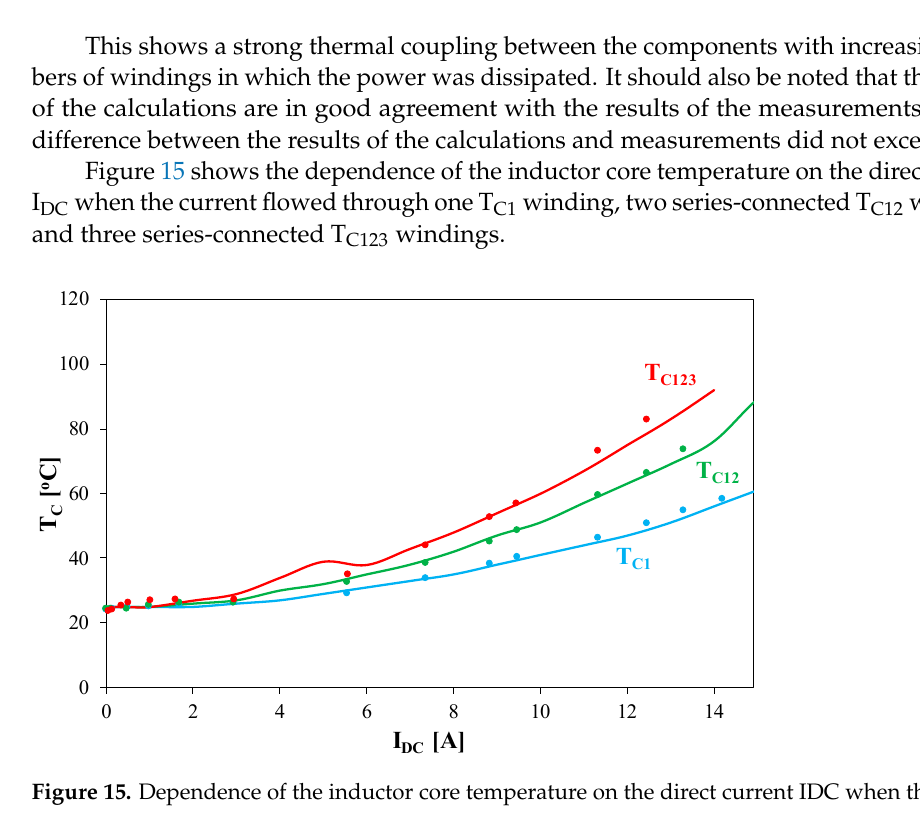
Figure 14. Dependence of the temperature of the inductor components on the direct cur ‐ rent ( a ) when power is dissipated in one winding, ( b ) when the power is dissipated in three series ‐ connected windings.